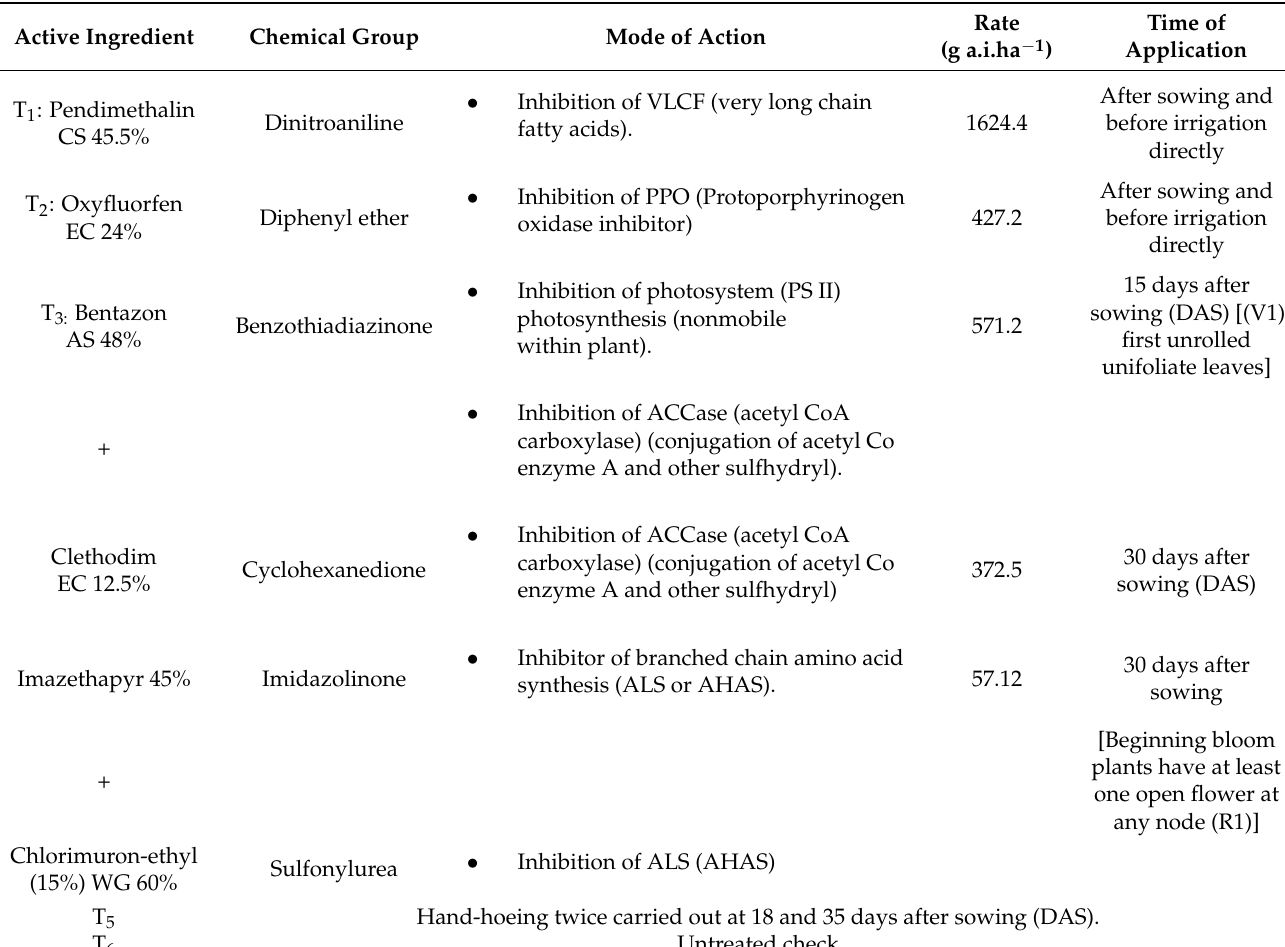
Table 4. Common, chemical names, chemical group, mode of action rate and time of the test